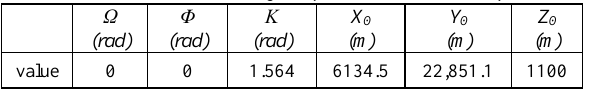
Table 1 Initial values for object space transformation parameters